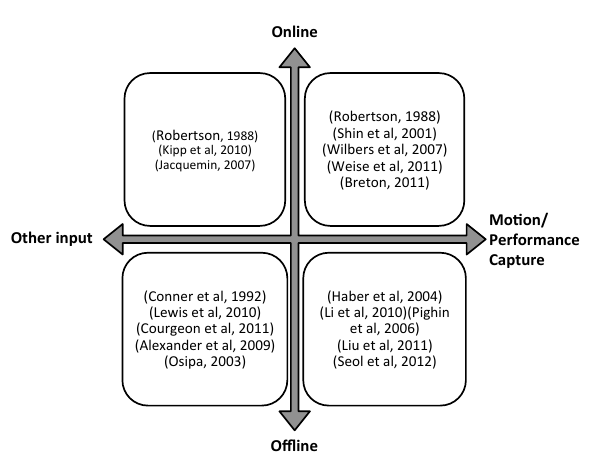
Figure 2. A comprehensive classification of the related work.